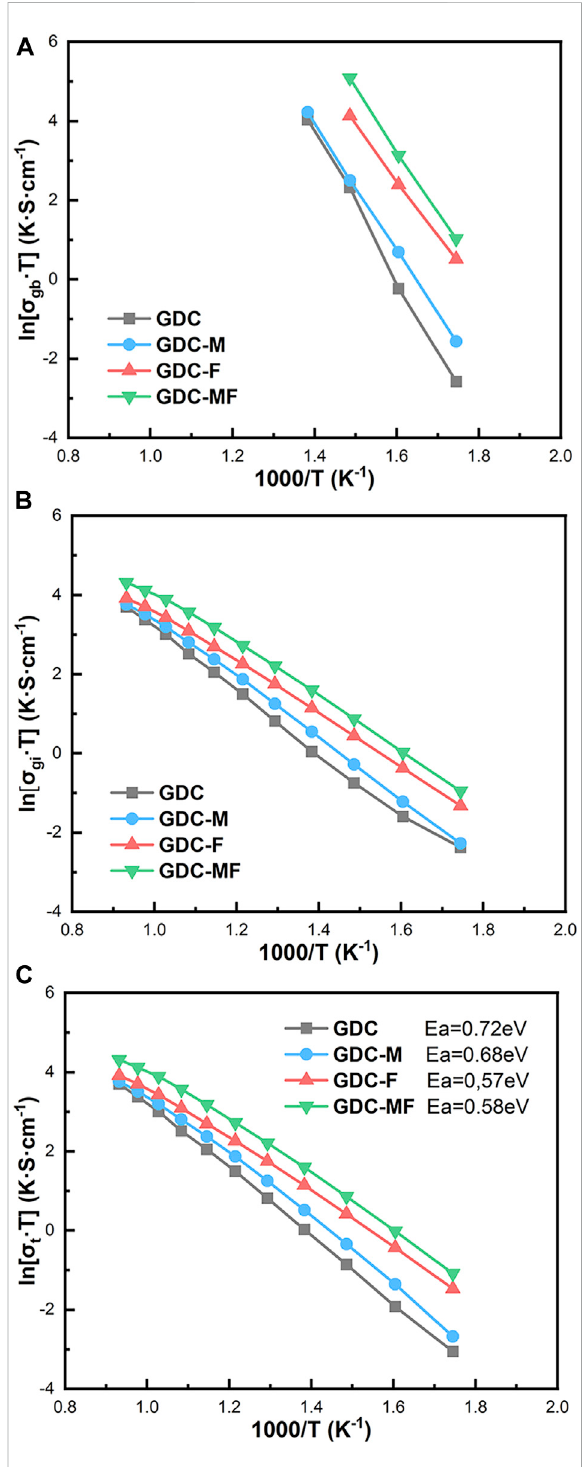
FIGURE 6 Arrhenius curves of (A) σ gb , (B) σ gi , and (C) σ t of GDC-based electrolytes.